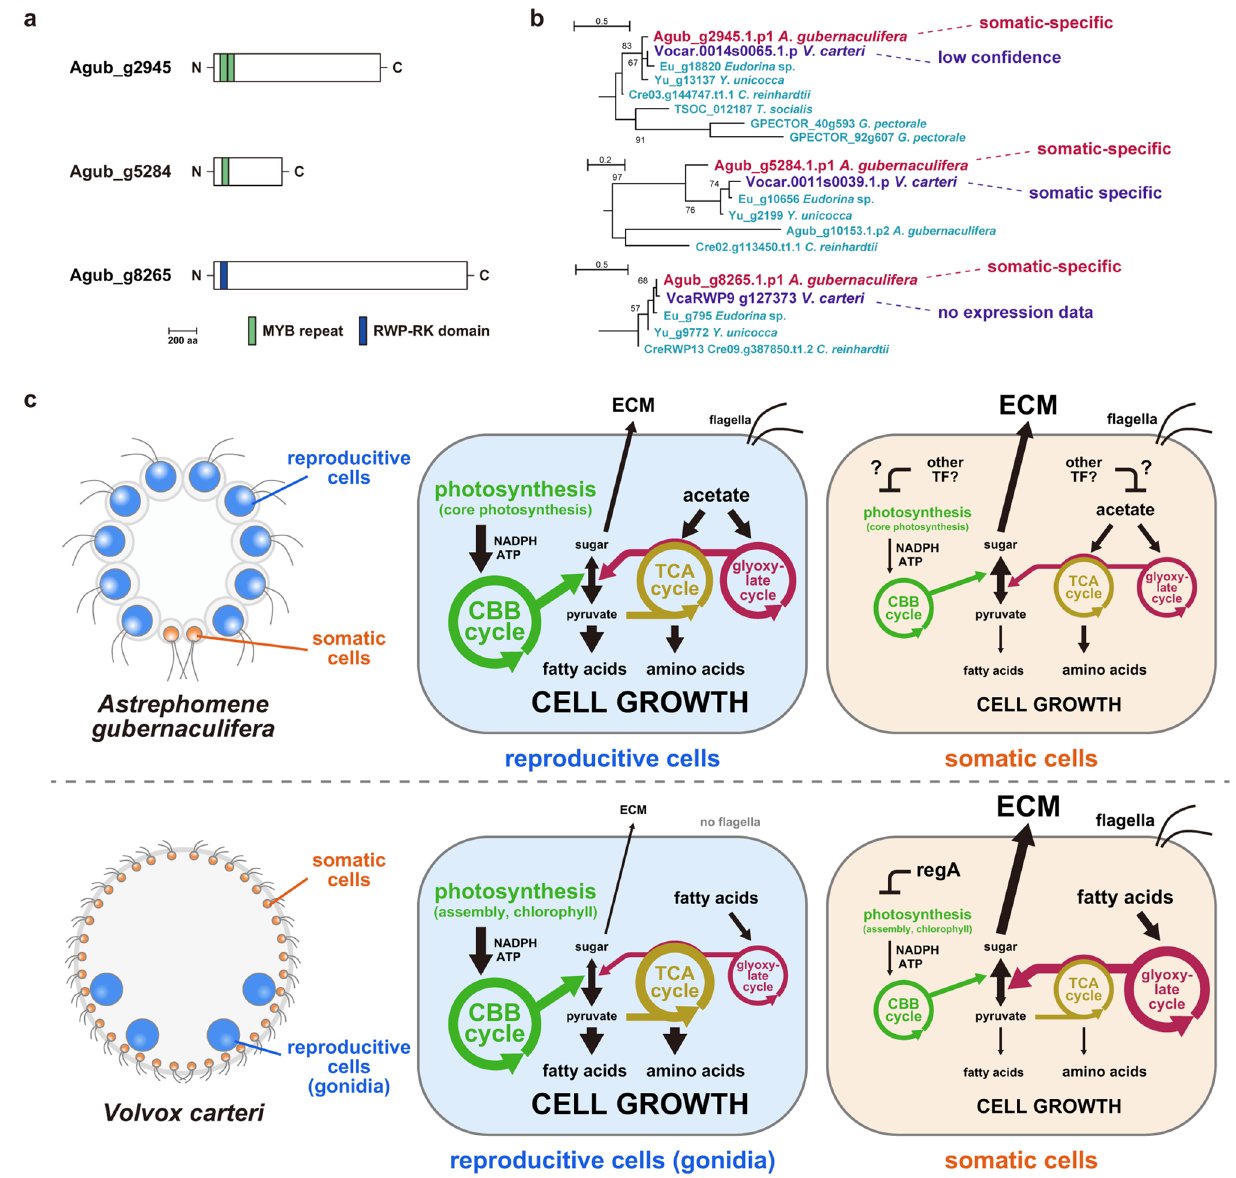
Figure 4. Characteristics of somatic-specific transcription factors in Astrephomene gubernaculifera . ( a ) The domain structure of Agub_g2945, Agub_g5284 and Agub_g8265. ( b ) Phylogenetic relationships of Agub_g2945, Agub_g5284 and Agub_g8265 among related transcription factors. The whole phylogenetic trees are shown in Supplementary Figs. 13, 14. The classification of Volvox carteri homologs were based on the previous study 32 , though VcaRWP9 is not found in V . carteri ver. 2.0 or 2.1 genome data and therefore there is no expression data for it. ( c ) Schematic diagrams of the comparison of germ–soma differentiation in A. gubernaculifera and V. carteri . The simplified metabolic pathways in A . gubernaculifera are based on this study, and those in V . carteri are based on a previous study 32 . The size of letters and thickness of arrows indicate gene expression levels. See also Fig. 3c,d and Supplementary Figs. 10, 11,